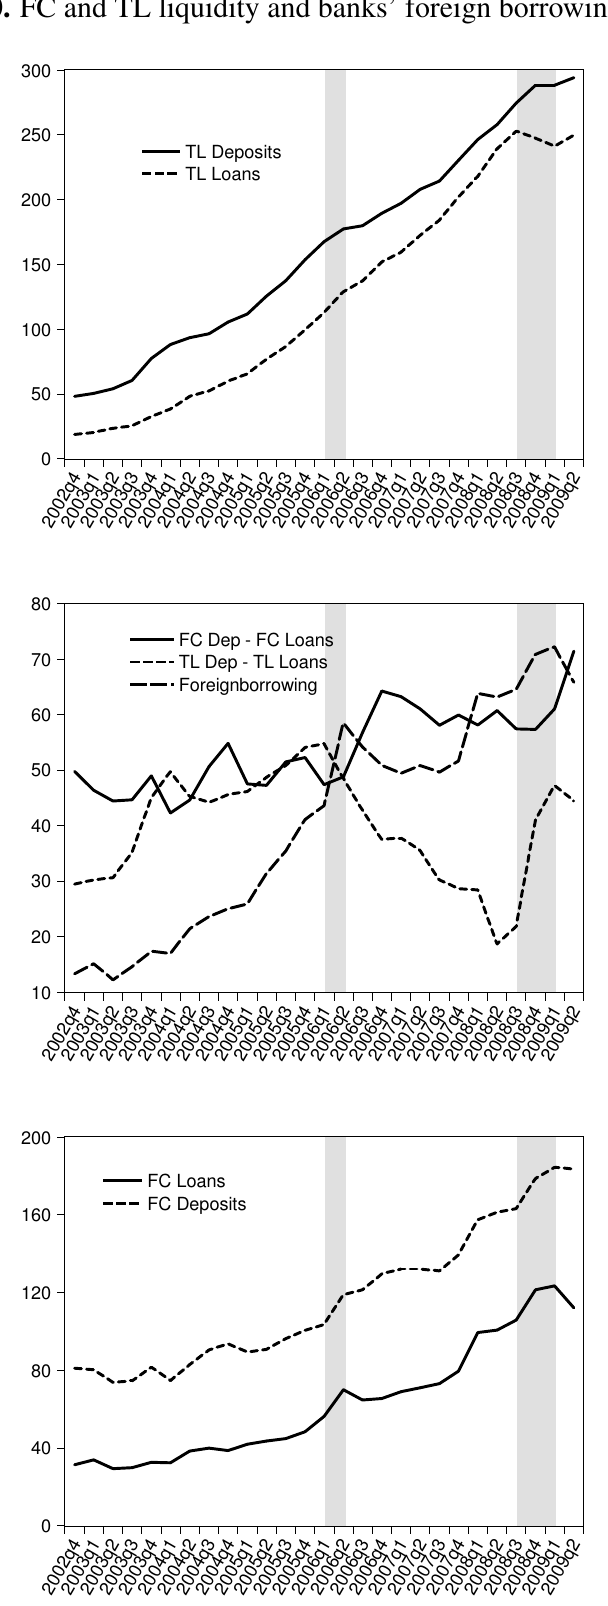
Figure 10. FC and TL liquidity and banks’ foreign borrowing